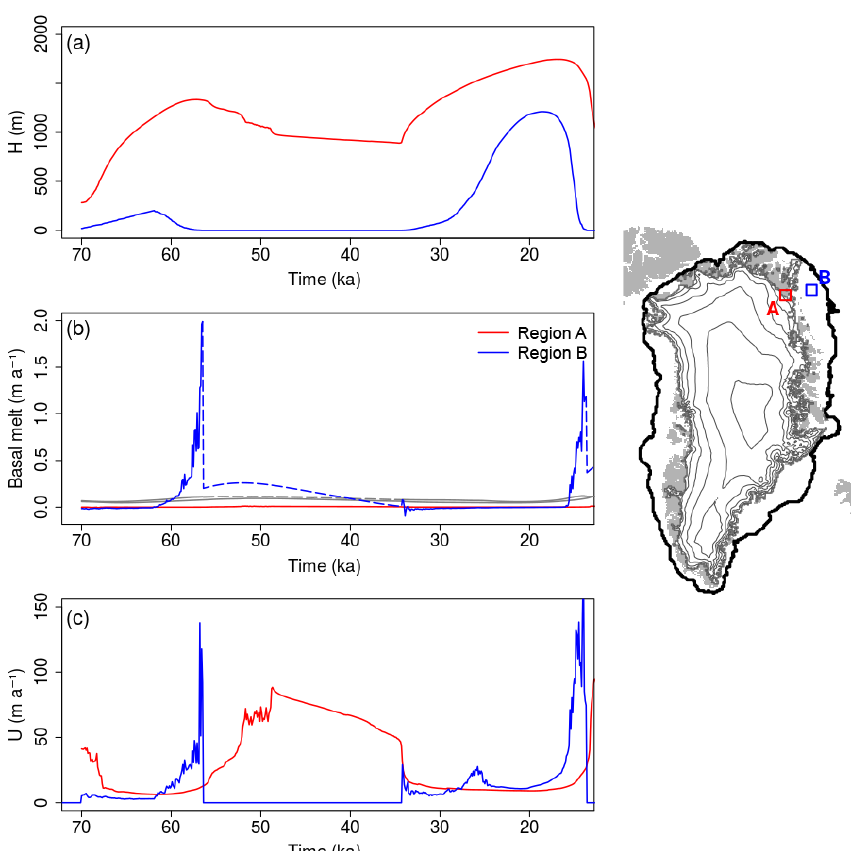
Figure 6. Evolution of the ice thickness (a) , basal melt (b) and ice velocity (c) averaged within the regions A (red lines) and B (blue lines), simulated in the presence of submarine melt during MIS-3 ( κ = 8ma − 1 K − 1 experiment). Grey lines in (b) show the contribution to surface mass balance (accumulation minus ablation) simulated by the model and averaged over the regions A and B. Dashed lines in the same panel show the potential contributions that would be observed if regions A and B were ice-covered. The black line on the side map represents the LGM maximum extent for the κ = 8ma − 1 K − 1